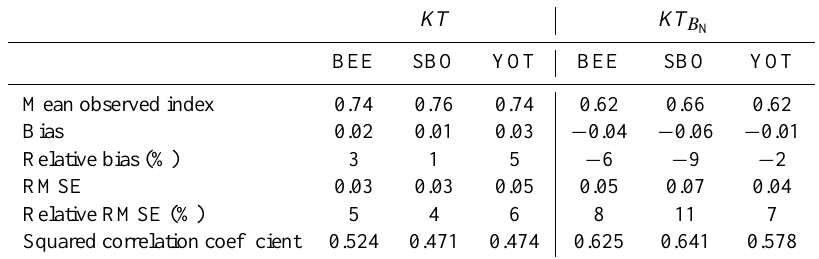
Table 4. Comparison between clear-sky clearness indices KT and KT B